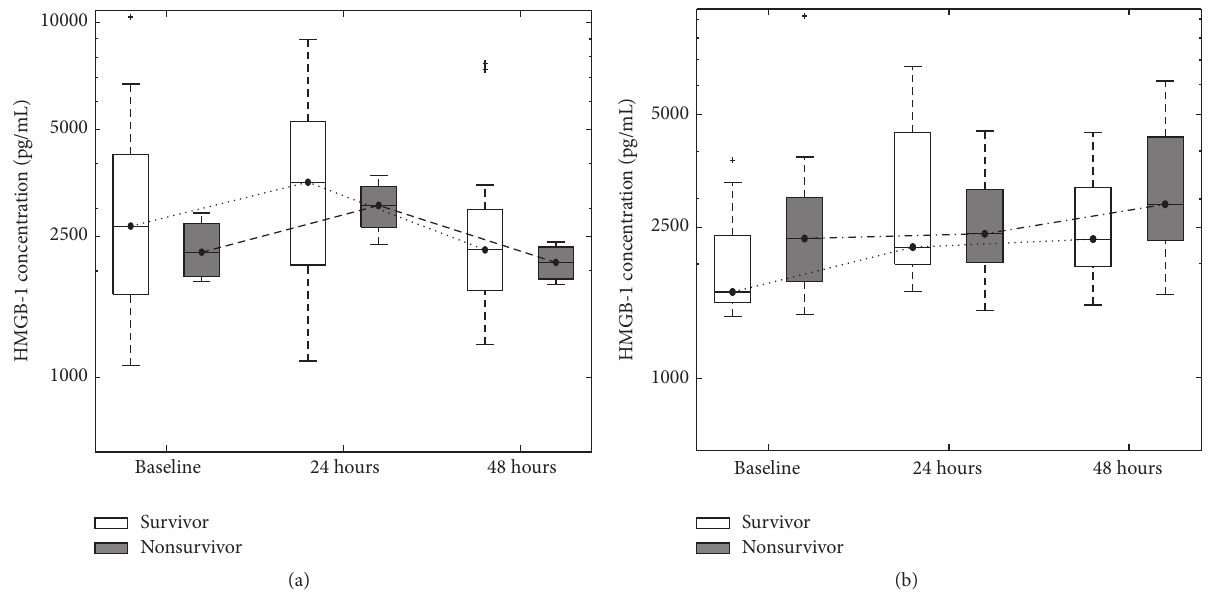
Figure 3: Plasma HMGB-1 levels in relation to TAC applied and survivorship at baseline and at 24 hours and 48 hours after allocation. (a) shows data for the ANPTT allocation (22 patients total: 18 survivors, 4 nonsurvivors). (b) shows data for the BVP allocation (22 patients total: 11 survivors, 11 nonsurvivors). The “+” symbol represents outliers, which were plotted separately.